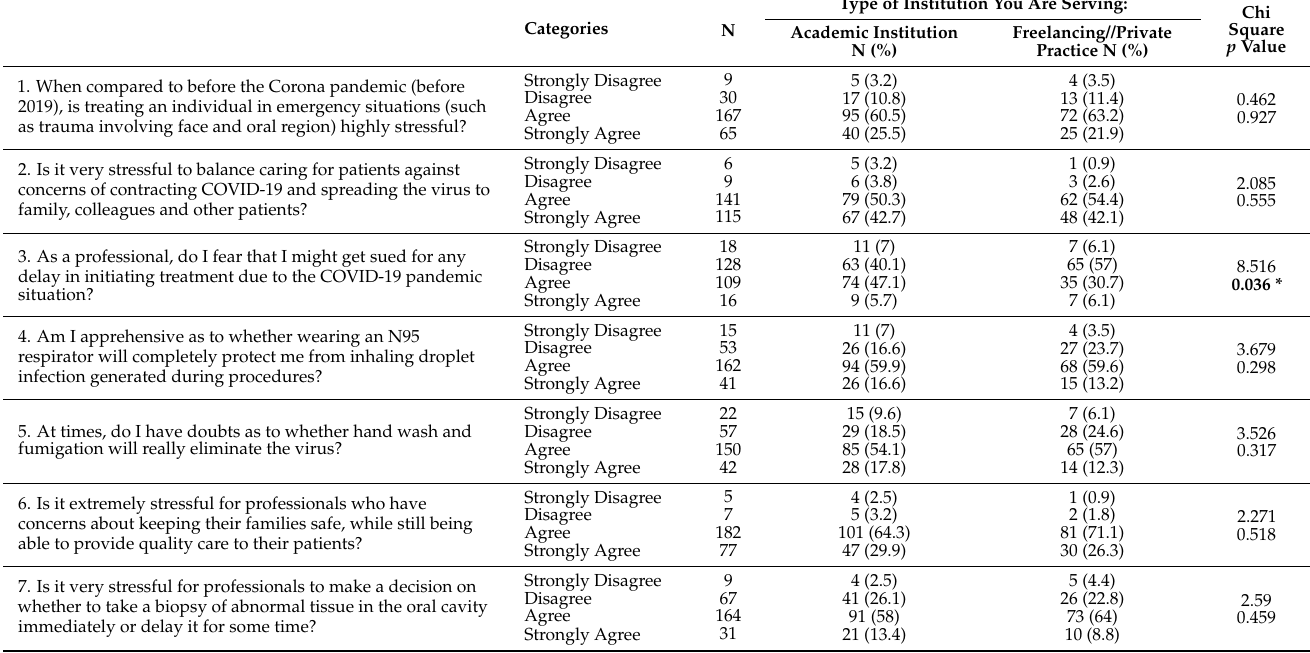
Table 2. Chi square test to compare the question 10 with all the other